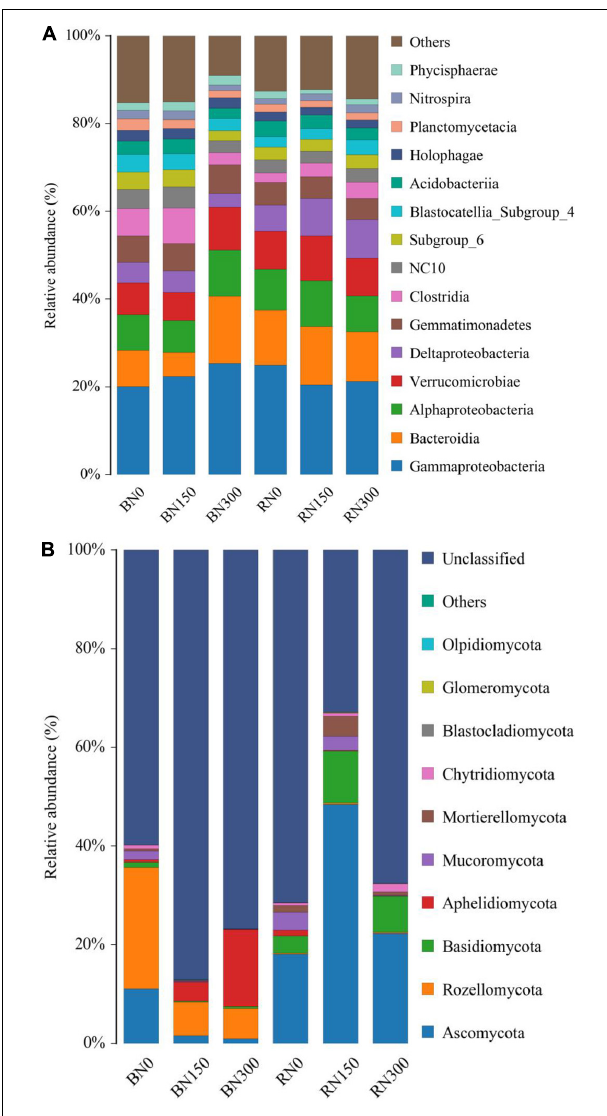
FIGURE 4 | The functions of bacterial communities and ecological functions of fungal communities, were explored using FAPROTAX (A) and FUNGuild (B) ,